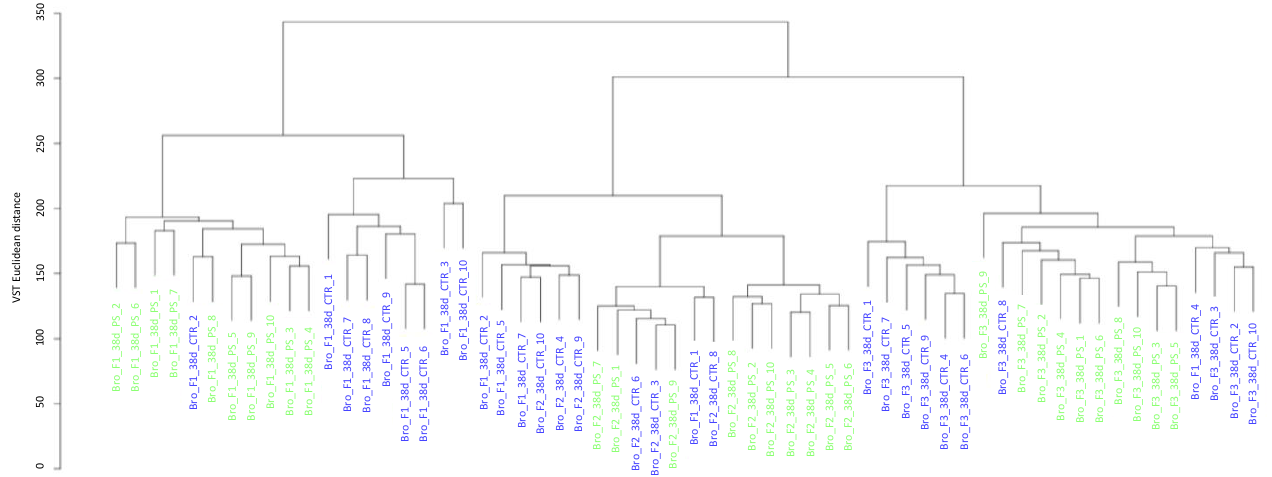
Figure 4. Dendrogram of caecal content samples, clustered on the euclidean distance between their taxonomic count data. Samples are color-coded by treatment (green for synbiotic-treated chickens, blue for control ones).